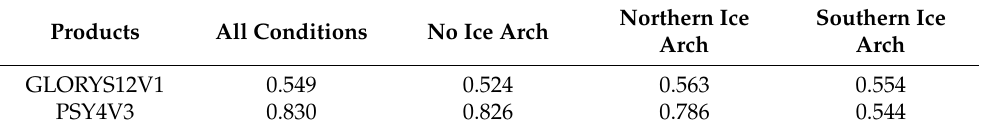
Figure 9. Grouped scatter plots of the ice floe speed from Sentinel-1 versus the speed from the two assessed sea ice motion products ( a , c , e ) GLORYS12V1 and ( b , d , f ) PSY4V3. Data in the top, middle and bottom rows are extracted from periods of no arch, northern arch, and southern arch, respectively. The diagonal solid gray lines are the 1:1 lines. The dashed black lines are the fitting lines. Table 3. Correlation coefficient ( R ) values between the ice floe drift and the sea ice motion products under different conditions in the Robeson